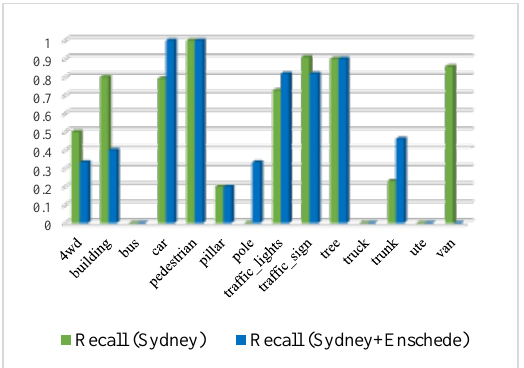
Figure 3. The Recall of Vox-Net classification with and without a complementary dataset.